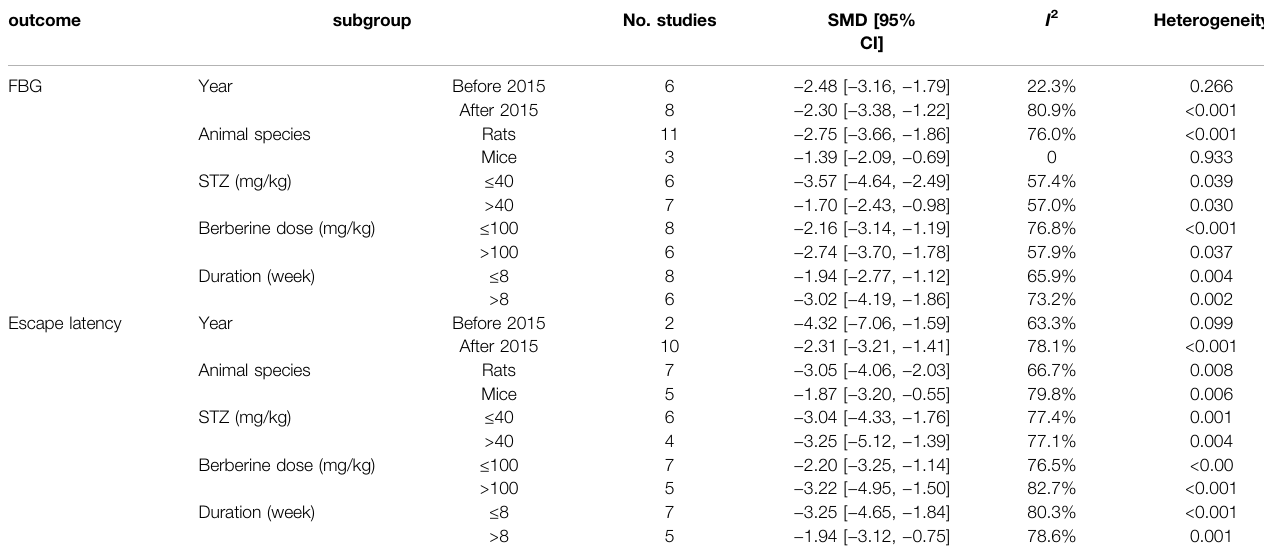
TABLE 4 | Subgroup analyses of berberine on FBG and escape latency.